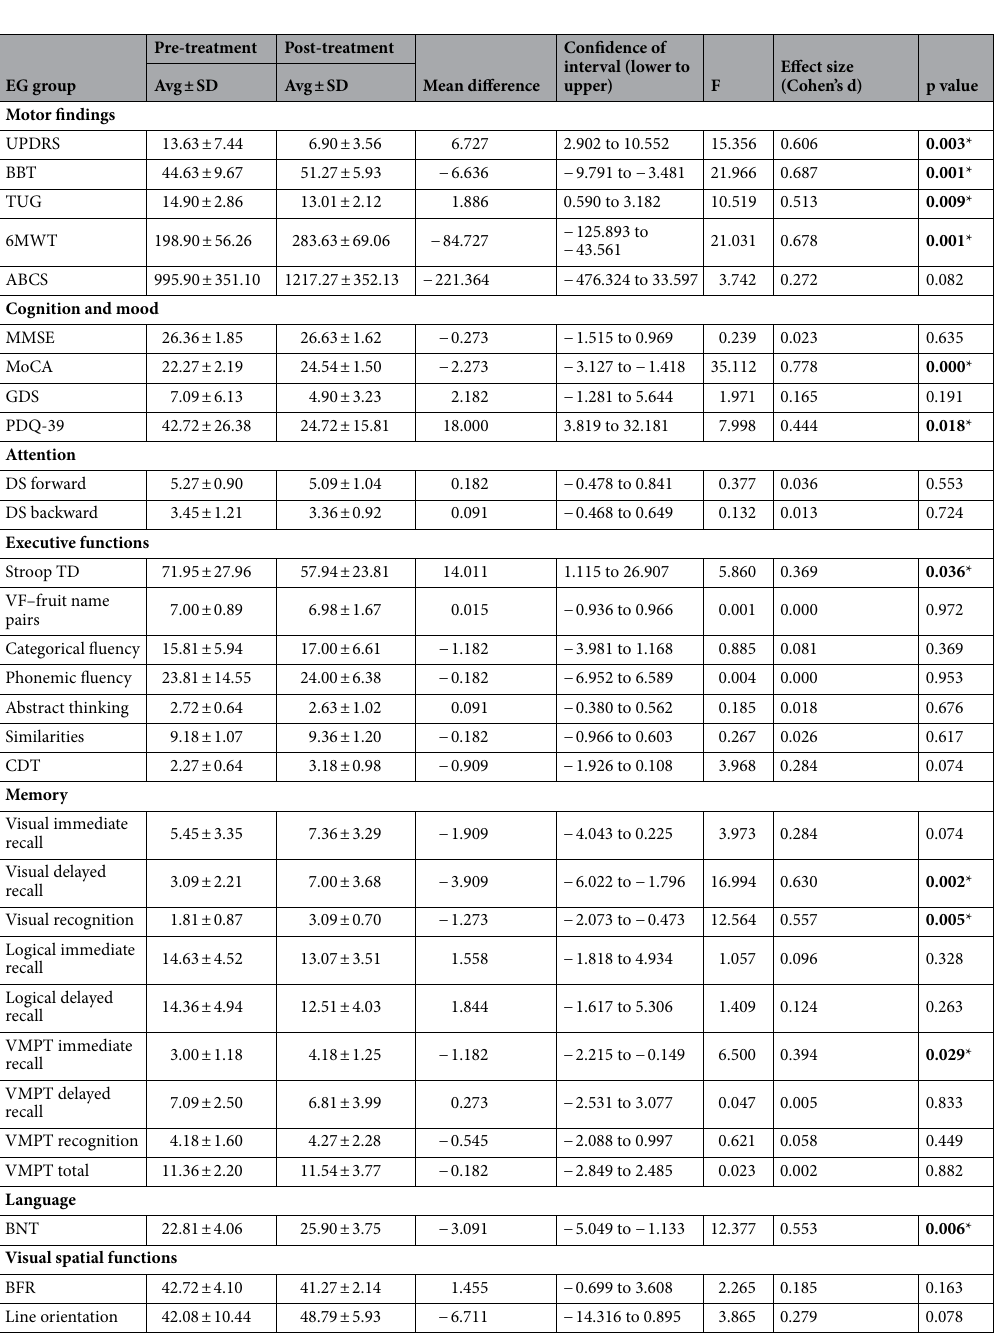
Table 2. Within group findings in EG group. Avg average, SD standard deviation, UPDRS Unified Parkinson’s Disease Rating Scale, BBT Berg Balance Test, TUG Timed-up and Go Test, 6MWT 6 min walk test, ABCS Activities-specific Balance Confidence Scale, MMSE Mini-Mental State Examination, MoCA Montreal Cognitive Assessment, GDS Geriatric Depression Scale, PDQ-39 Parkinson’s Disease Questionnaire, TD Time Difference, VF Verbal Fluency, CDT Clock Drawing Test, VMPT Verbal Memory Process Test, BNT Boston Naming Test, BFR Benton Face Recognition. * p < 0.05